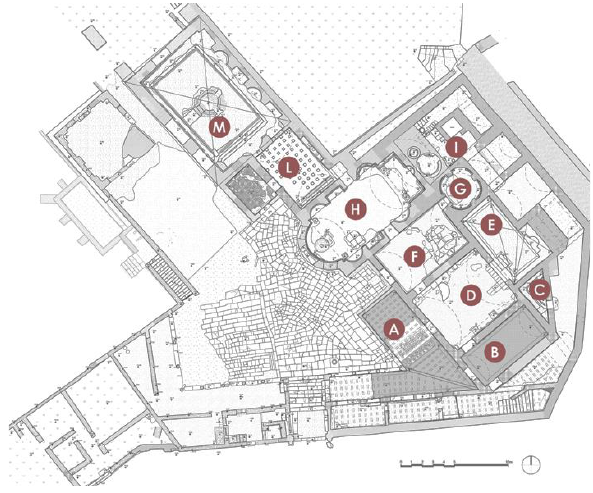
Figure 10. Planimetry of the Suburban Thermal Baths with the indication of the functions of the rooms: A. Entrance lock room, B. Apodyterium; C. Latrinae; D. Frigidarium; E. Cold Natatio; F. Tepidarium; G. Laconicum; H. Calidarium; I. Boilers; L. ‘Warm’ space; M. Warm Natatio. (Designed by: L. Cappelli).